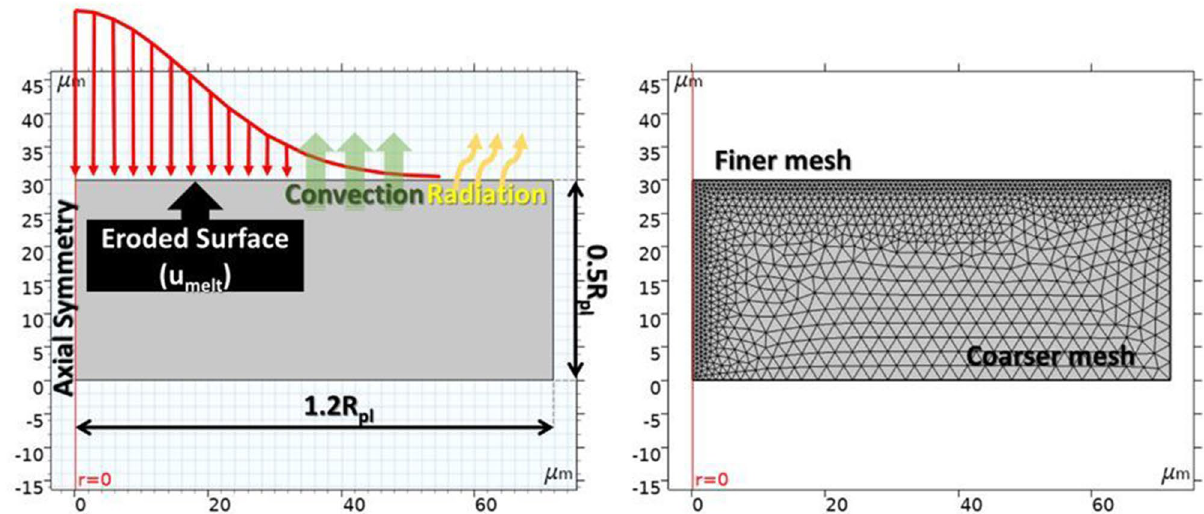
Figure 4. Model’s boundary conditions and meshing.